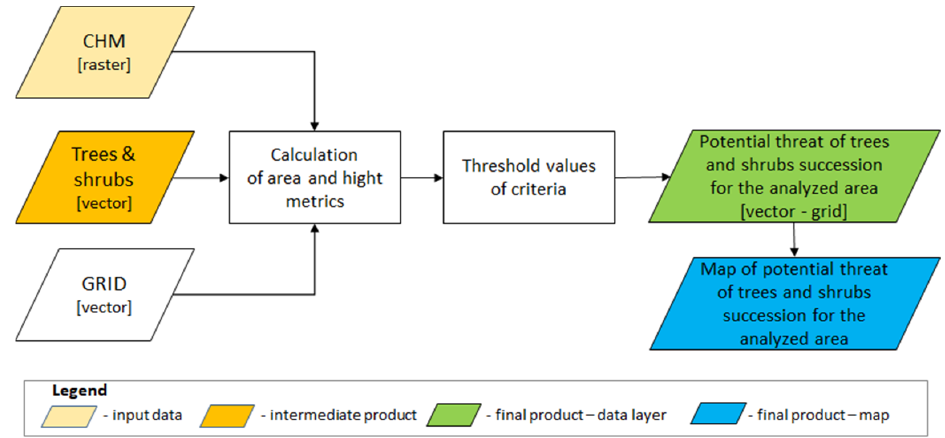
Figure 4. Scheme of Step 3—determining the level of potential threat of the succession process for the analysed area. the analysed Table 3. The criteria used to define the levels of potential threat of succession for the whole analysed area.